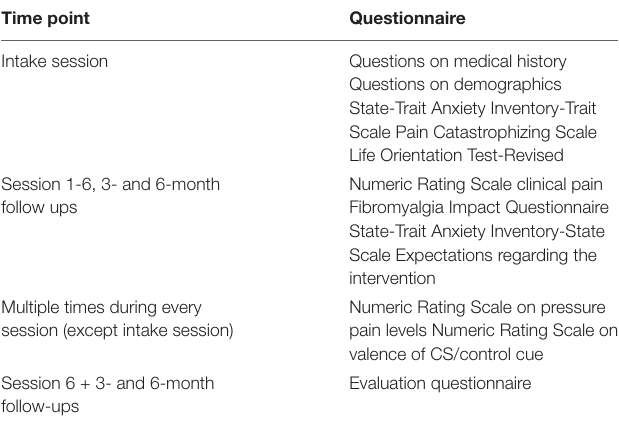
TABLE 1 | Overview of administered questionnaires throughout the